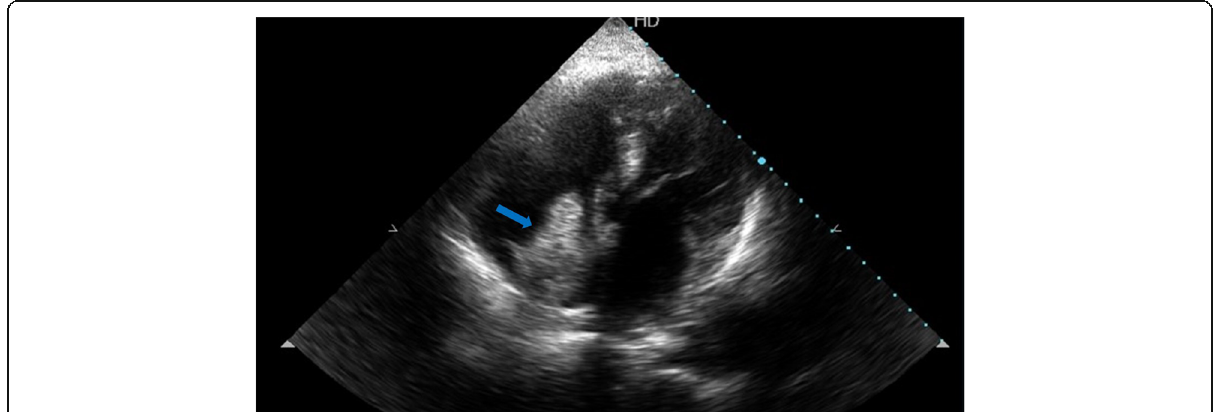
Fig. 1 TTE apical four-chamber view showing a large mass in the right atrium marked by a blue arrow